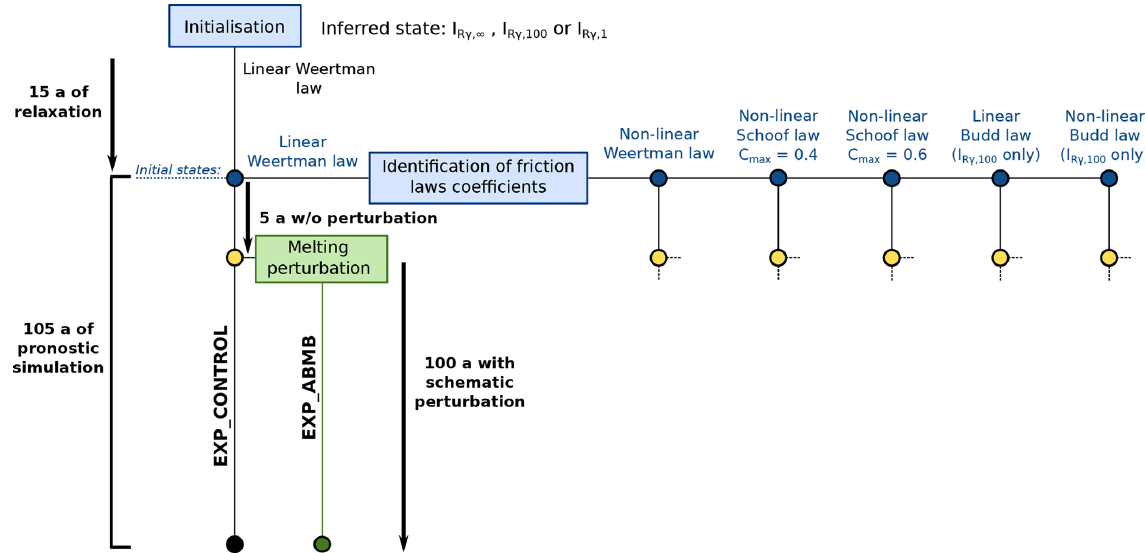
Figure 2. Flow chart summarising the consecutive steps of the present study for a given inferred state. The simulations EXP_CONTROL and EXP_ABMB are run for each of the five friction laws. The same procedure is repeated for each of the three inferred states, I R and I R , except that the non-linear and linear Budd friction laws are applied only to the inferred state I R γ, 1